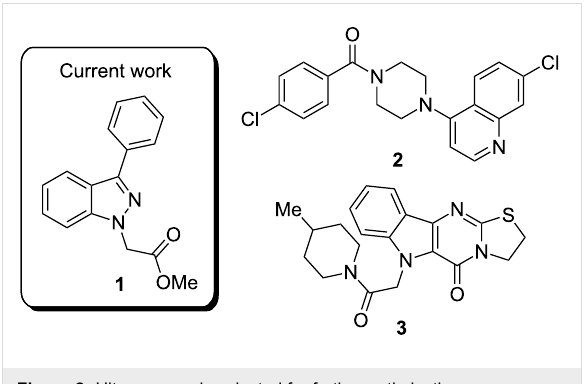
Figure 2: Hit compounds selected for further